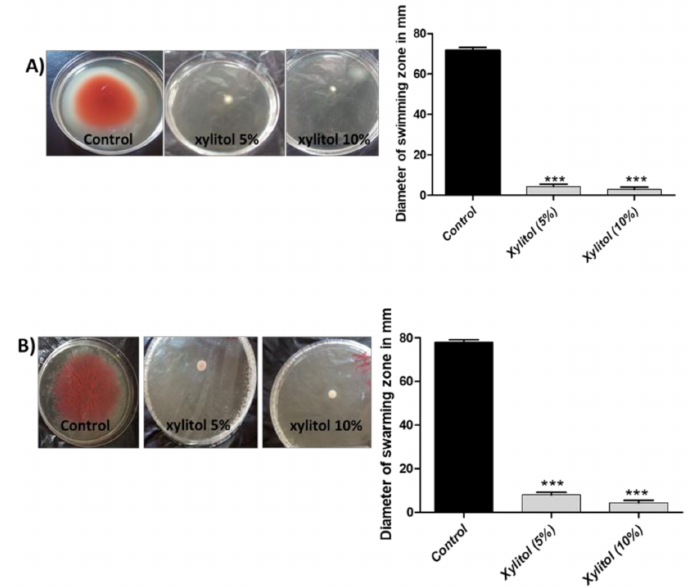
Figure 4. Inhibition of bacterial motility by xylitol. ( A ) Swimming LB agar plates with xylitol and control plates were center stabbed with 5 µ L from an overnight culture of S. marcescens and the diameter of swimming zones were measured. The test was performed in triplicate. Xylitol significantly reduced swimming motility. The data shown are the means ± standard errors. One- way ANOVA test followed by Dunnett’s Multiple Comparison test was used for statistical analysis.